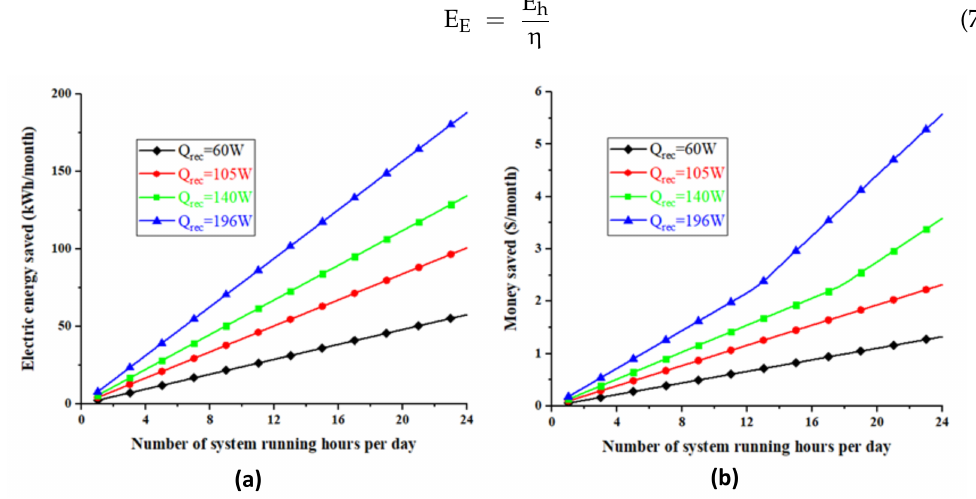
Figure 5. ( a ) Amount of electric energy saved by the system for different running hours, and ( b ) amount of money economized by utilizing the recovery